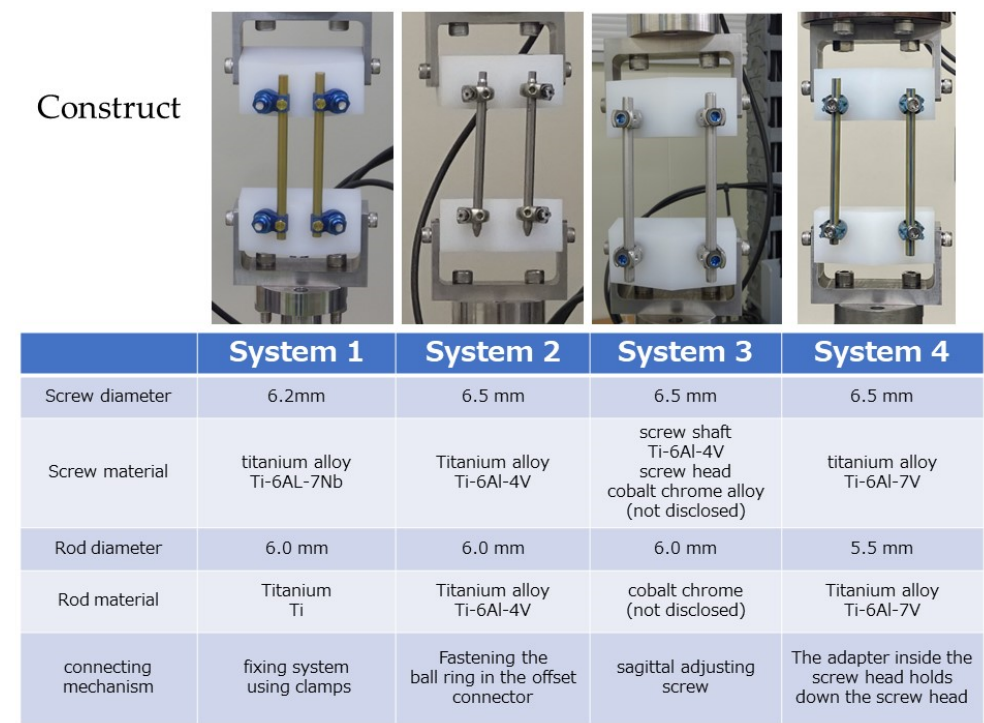
Figure 2. Data of the four spinal systems used in this experiment.